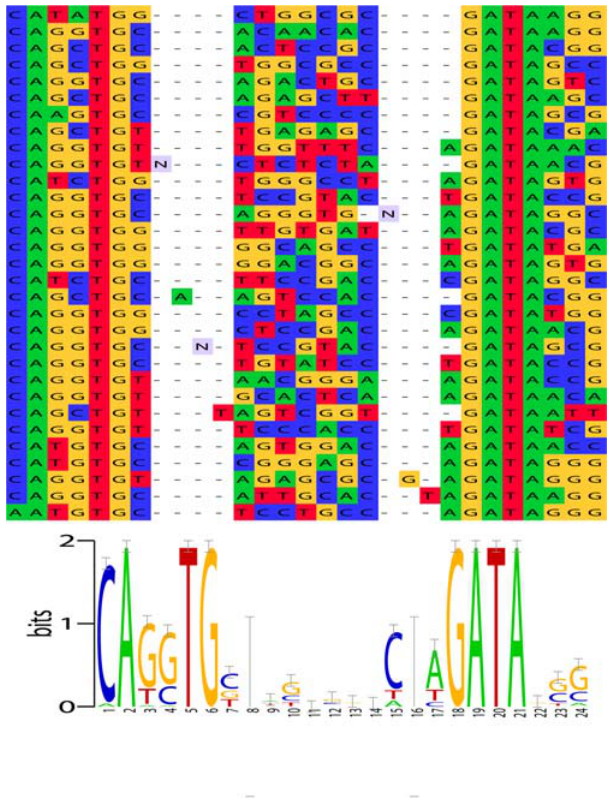
Figure 5. GLAM 2 output on 31 clones that bind the Lmo2 complex. GLAM 2 was run using default parameters on the clones identified in Figure 1A of [46]. The GLAM 2 alignment is shown on the top, and the information content ‘‘LOGO’’ corresponding to the alignment is shown on the bottom. The GLAM 2 alignment was pretty-printed using PFAAT [60]. The LOGO is corrected for small-sample size